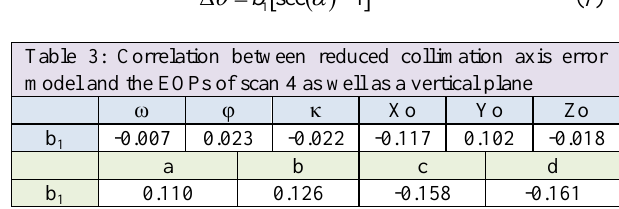
Table 5: Significant systematic error terms in the plane-based